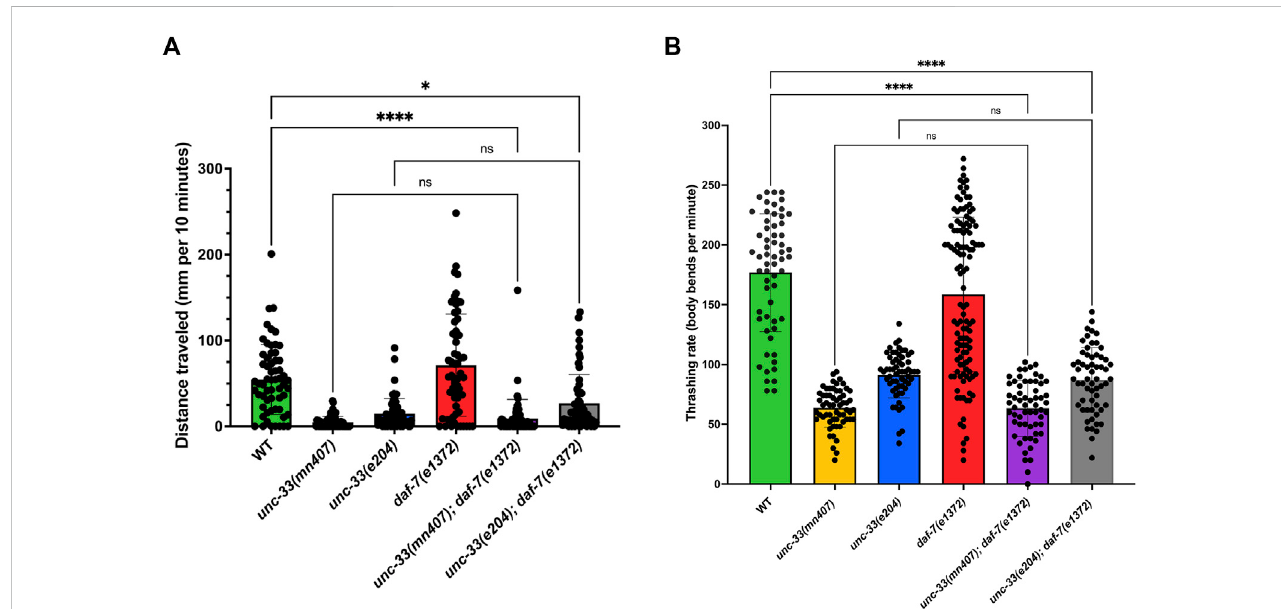
FIGURE 2 Double mutant unc-33; daf-7 dauers have similar rates of locomotion to unc-33 single mutant nematodes (A) The average distance traveled in millimeters per 10 minutes for each strain on a plate seeded with E. coli OP50 is plotted. (B) Average thrashing rate (body bends per minute) of each strain placed in liquid media. Statistical analyses using Kruskal – Wallis ’ s tests followed by Dunn ’ s multiple comparisons show no signi fi cant differences (ns) between doublemutants unc-33;daf-7 andtheir unc-33 single mutantcounterpart. However, unc-33(mn407) and unc-33(e204) werestatistically differentfrom wildtype ( p < 0.0001). n = 60 animals per strain.